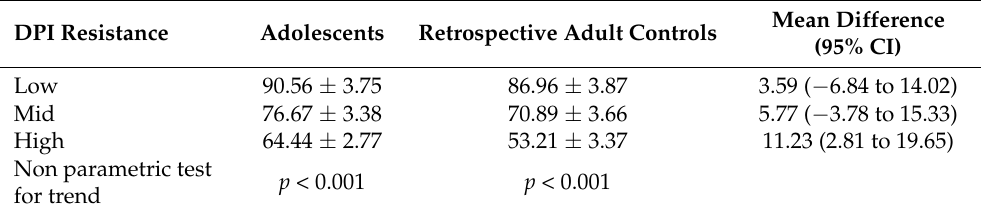
Table 2. Mean inspiratory flow (L/min) ± standard error measured at the three resistance regimens. DPI